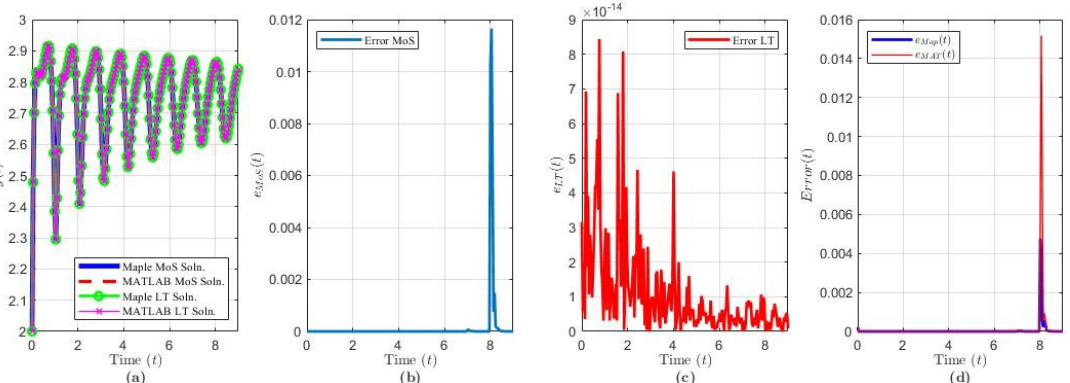
Figure 2. Solution results of Equation (19) over t ∈ [ 0,9 τ ] ( n = 5000 terms): plot of ( a ) the solution